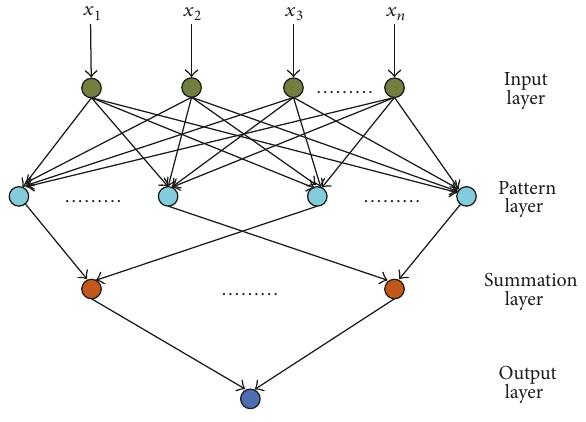
Figure 5: General configuration of PNN.